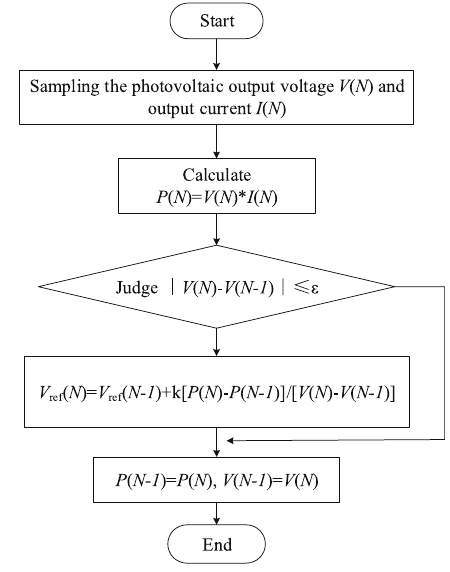
Fig. 1 Basic architecture of household-level electric power router